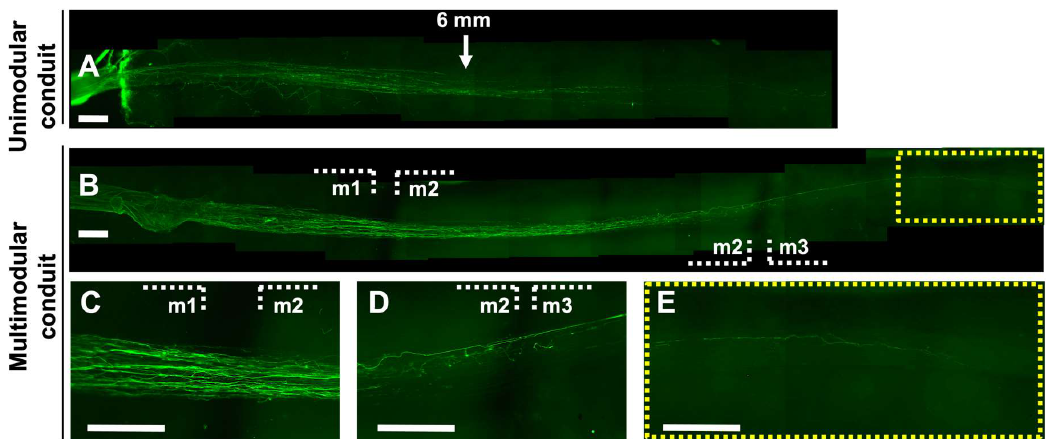
Figure 6. Axon growth in unimodular and multimodular conduits after 21-days dorsal root ganglion explant culture. Representative fluorescence reconstruction of the ( A ) unimodular and ( B ) multimodular conduit’s complete length after neuronal staining with Tuj1 (green), showing greater axonal extension of the multimodular conduit. Fluorescent image of a longitudinal section of ( C ) inter-module zone between modules 1 and 2 (m1, m2), ( D ) inter-module zone between modules 2 and 3 (m2, m3), ( E ) final zone in module 3. White dash lines delimit the modules of the multimodular conduit, and yellow dash lines box delimit the final zone of the module 3 (16–17 mm long from the DRG explant). Scale bar: 500 µ